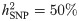
Theoretical predictions of power per causal SNP, for total sample size (x-axis) and CGR between two sets of studies (y-axis).Factor levels: 2 sets of 50 studies, CGR equal to 1 within both sets, 100k independent SNPs, and hSNP2=50% arising from a subset of 1k independent SNPs.